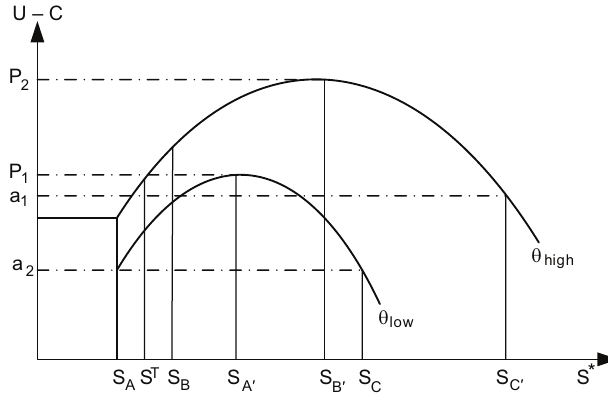
figure 3. The change of net utility for applicator with the change of value of S